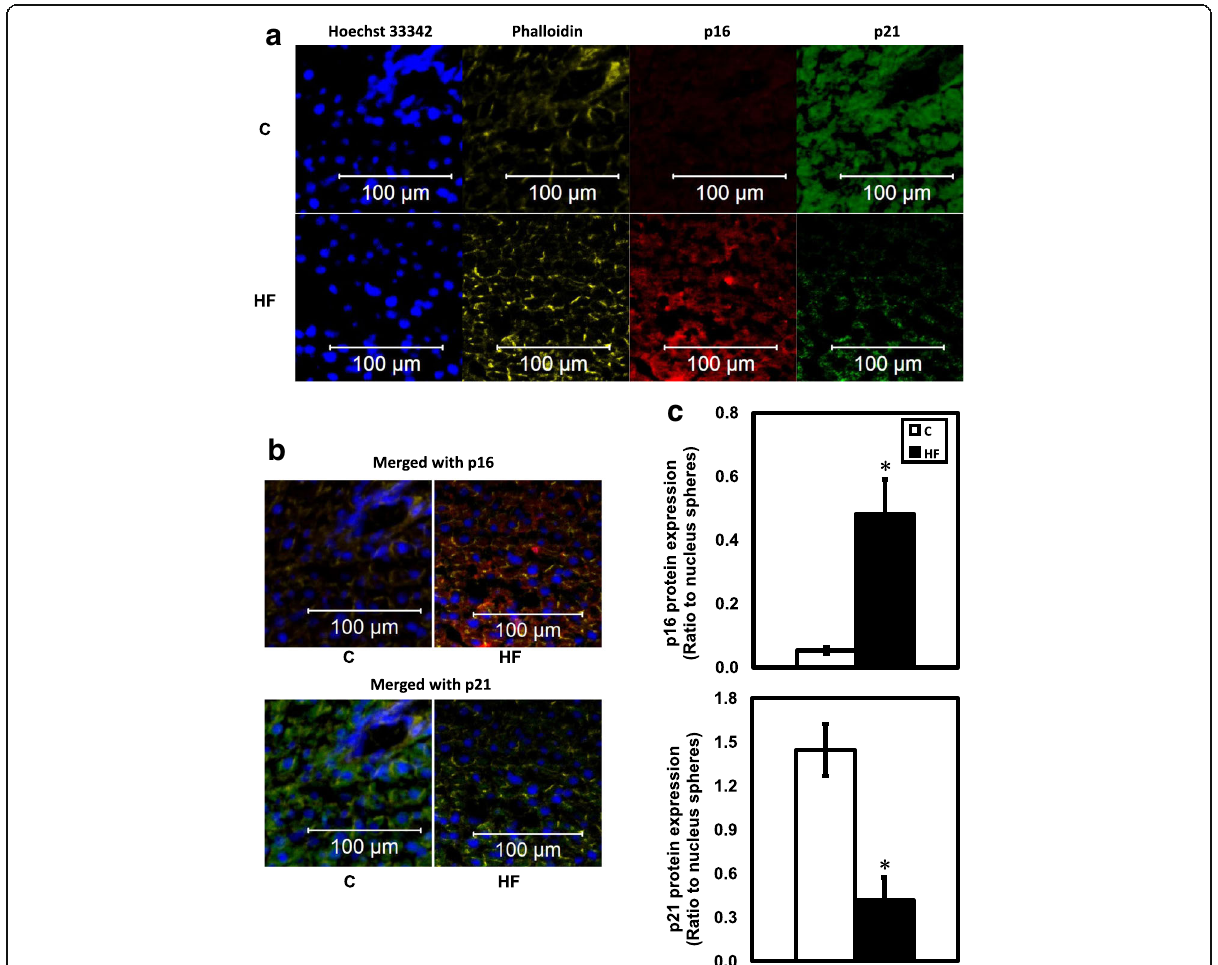
Fig. 4 Confocal immunofluorescent pictures (× 10) of rat livers and protein expression analysis. a Single channel pictures of stained nucleus (blue), actin filament (yellow), p16 INK4a antibody Alexa Flour 647 conjugated (red), and p21 Cip1 antibody Alexa Flour 488 conjugated (green). b Merged pictures (p16 INK4a/actin/nucleus and p21 Cip1/actin/nucleus, respectively) are selected and presented respectively to visualize protein quantification and localization. c p16 (INK4a) and p21 (Cip1) quantified protein level in C and HF rats as determined by immunofluorescence signal intensity ratio to nucleus signal intensity ( n = 5). Data are presented as protein immunofluorescent sphere area to nucleus sphere area. Values are mean ± SEM, P <